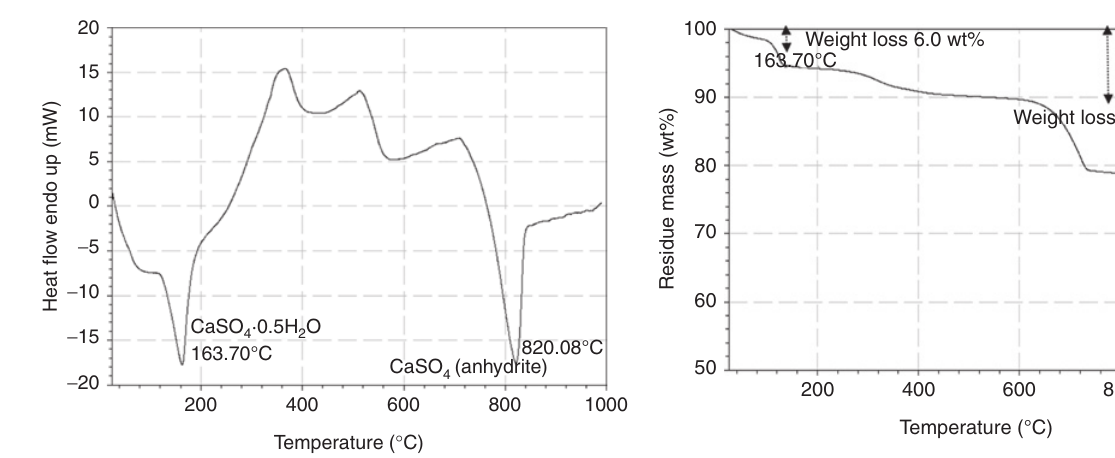
Figure 1: DTA measurement of the calcium sulfate dihydrate powder as prepared from the chemical reaction between duck eggshell and sulfuric acid from room temperature (25 ° C) to 1000 ° C.